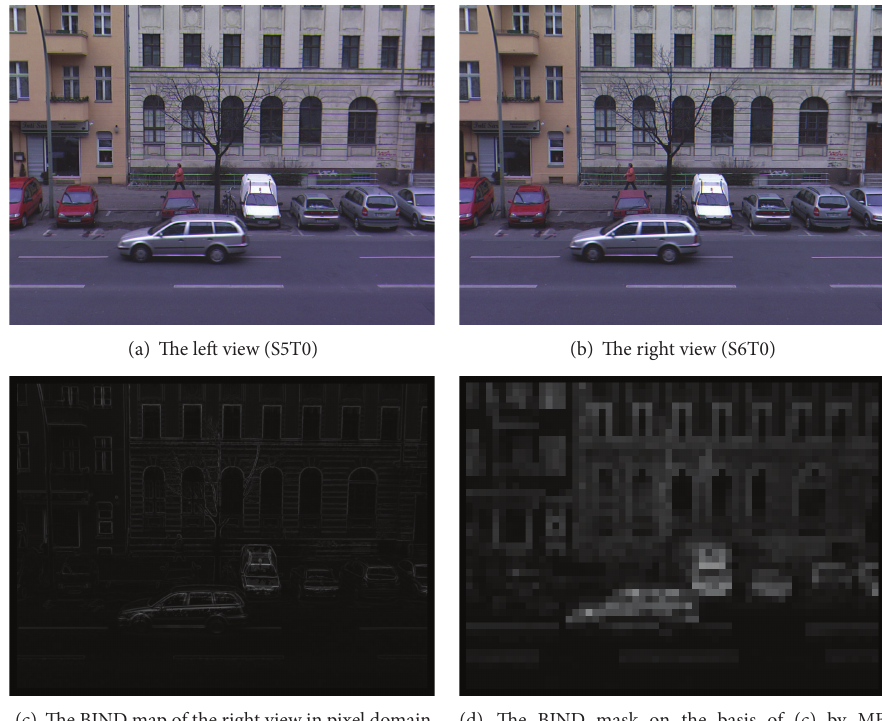
Figure 4: The BJND of AltMoabit